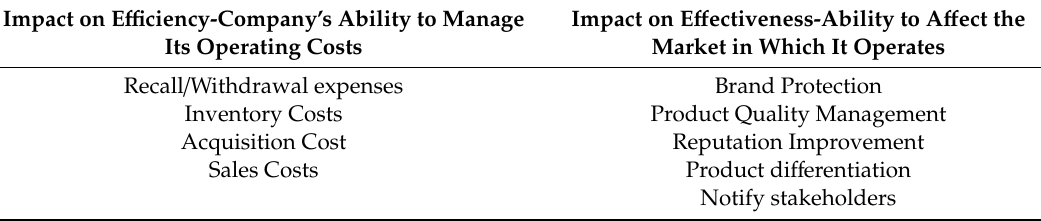
Table 2. Impacts of a drug traceability